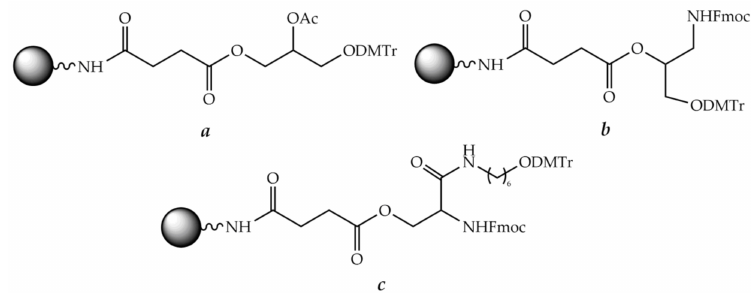
Figure 14. CPG supports for the introduction of aldehyde ( a , b ) or glyoxylic acid amide ( c ) groups at the 3 (cid:48) -end of an oligonucleotide.